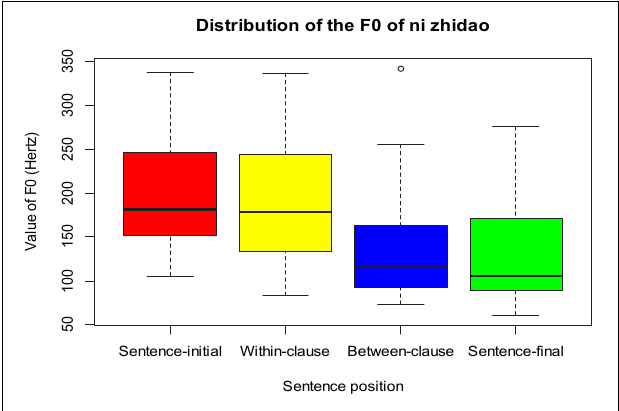
FIGURE 2 | Distribution of the F0 of ni zhidao in four sentence